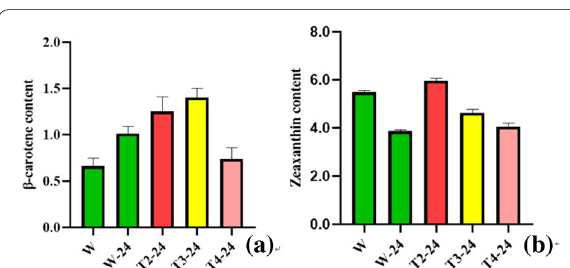
Fig.7 Content of β-carotene and zeaxanthin in D. salina after 24 h high light treatment (Values represented as mean β-carotene content of WT strain and mutants after 24 h high light treatment. b The zeaxanthin content of WT strain and mutants after 24 h high light